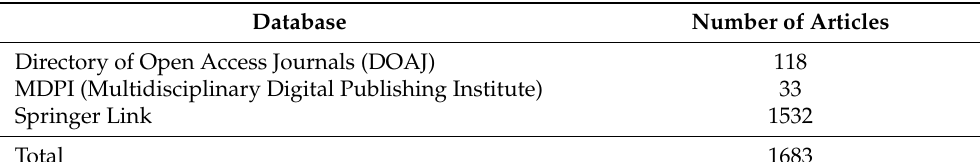
Table 1. Articles found in the databases under